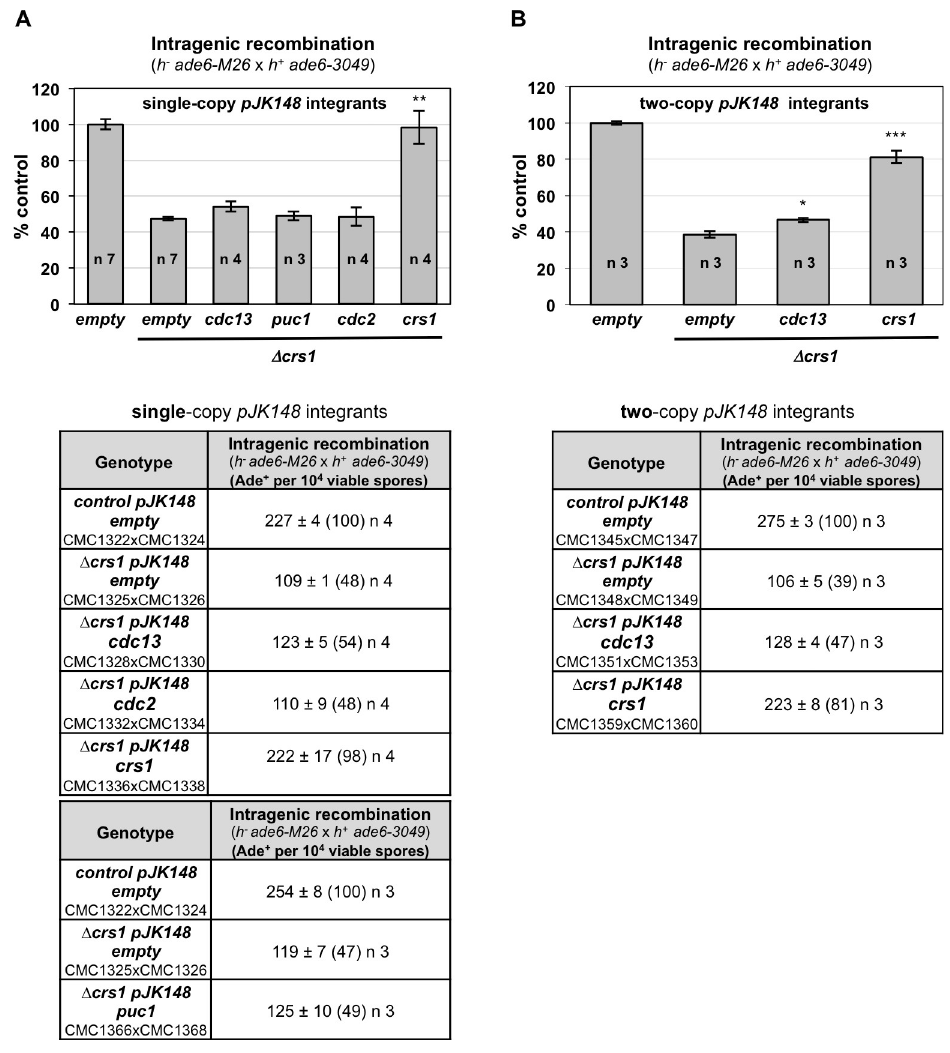
Fig 10. Increasing copy number of cdc13 , puc1 , or cdc2 does not restore recombination levels in Δ crs1 . Crosses of h - ade6-M26 x h + ade6-3049 were performed in SPA and plated for recombinant frequency at least twice. Tables at the bottom show gene conversion expressed as the mean of Ade + per 10 4 viable spores +/- SEM of n independent crosses based on the cumulative number of spore colonies in each cross; 71–293 Ade + colonies scored in each independent cross. The numbers in parentheses are percentages relative to the control integrant ( pJK148 empty ). Strains used in the crosses are indicated. Graphs at the top show gene conversion expressed as mean of the percentage relative to the control cross +/- SEM of n independent crosses. Each integrant was analyzed only with its control crosses ( pJK148 empty and Δ crs1 pJK148 empty ) in the same experiment. p values were calculated based on Student´s t-test (unpaired, two tails), � < 0.05, �� < 0.01, ��� < 0.001. (A) Single-copy integrants. (B) Two-copy